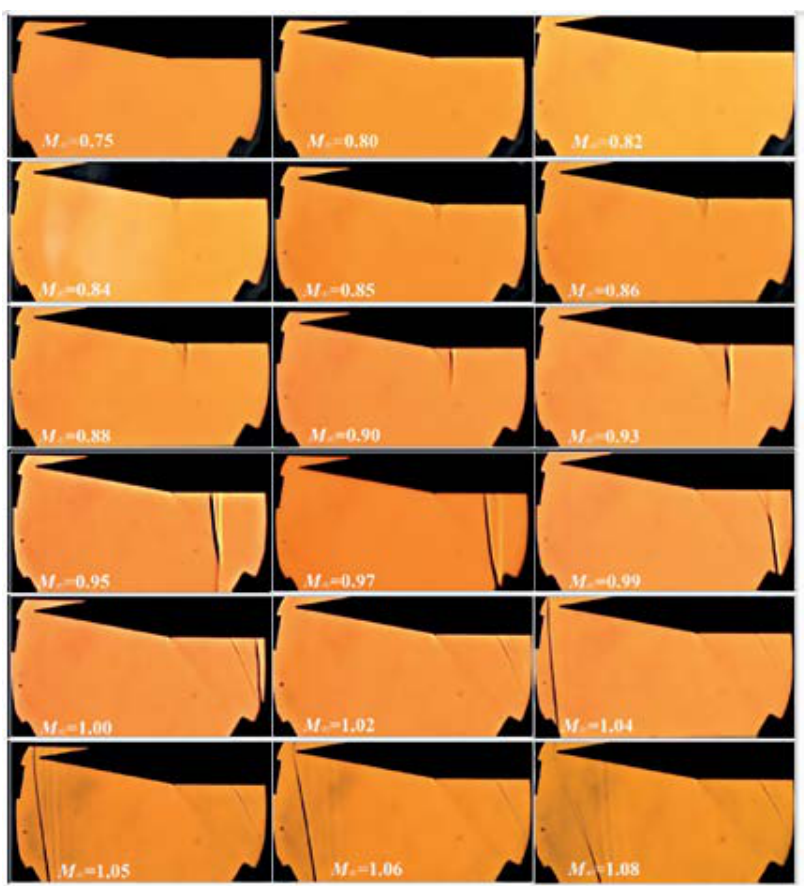
Figure 8. Schlieren images for model cone–cylinder forebody with blockage area ratio of 0.78%, for stagnation pressure of 80 kPa and stagnation temperature of about 300